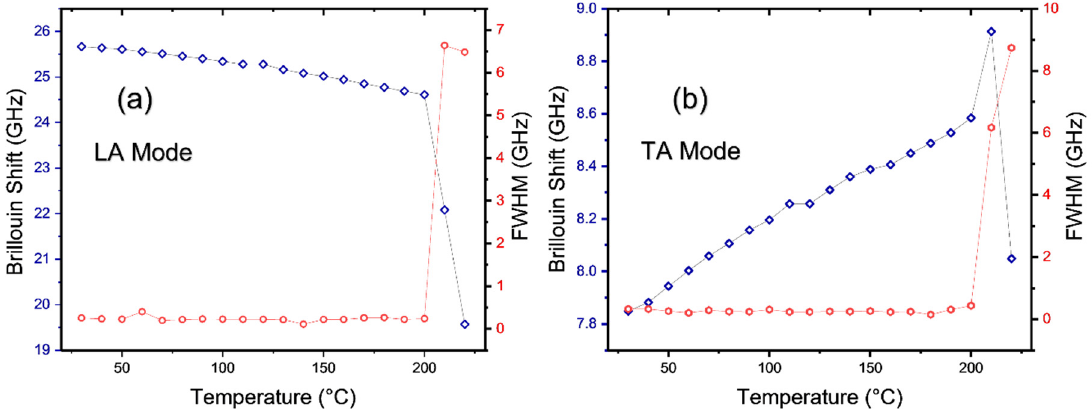
Figure 11. (Color online) Temperature dependence of the frequency (royal blue symbols) and the FWHM (velvet red symbols) of the LA ( a ) and the TA mode ( b ) measured by Brillouin scattering.